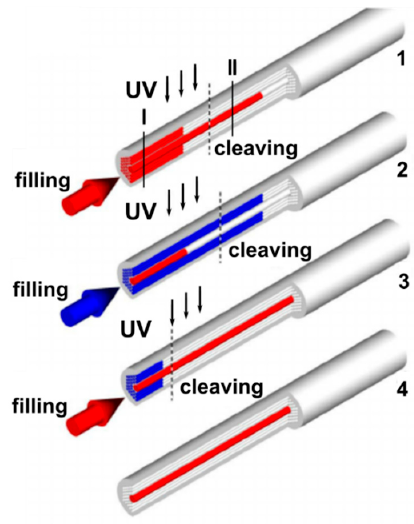
Figure 6. Schematic showing the selective filling of the central hollow-core and air-channels of the cladding of a MOF sample. Reproduced with permission from [48]. 1 —The optical ultraviolet (UV)-